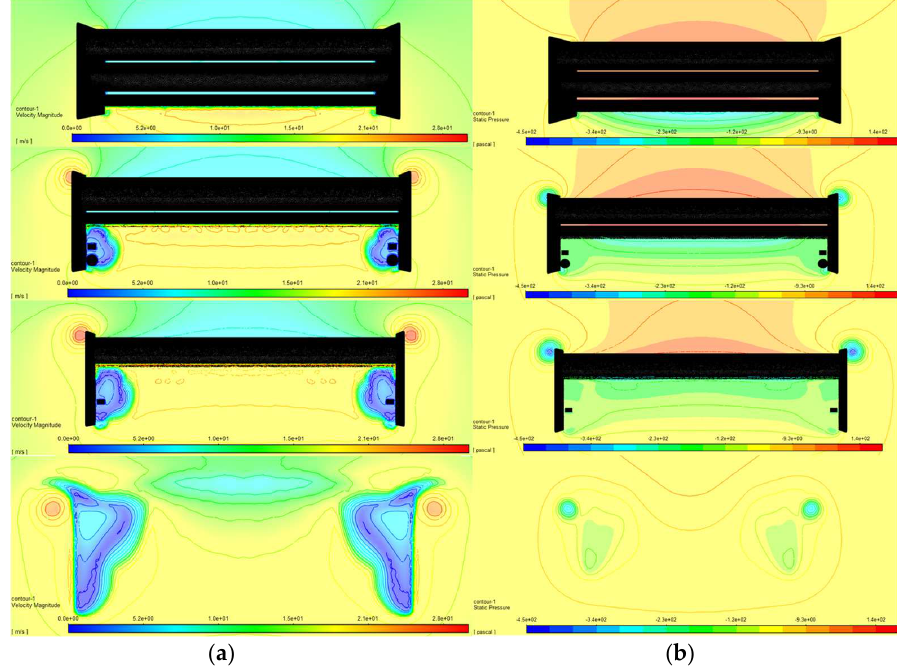
Figure 9. ( a ) Speed contour and ( b ) pressure contour for the multi-element wing with actuators. From top to bottom, different sections of the rear wing are represented.